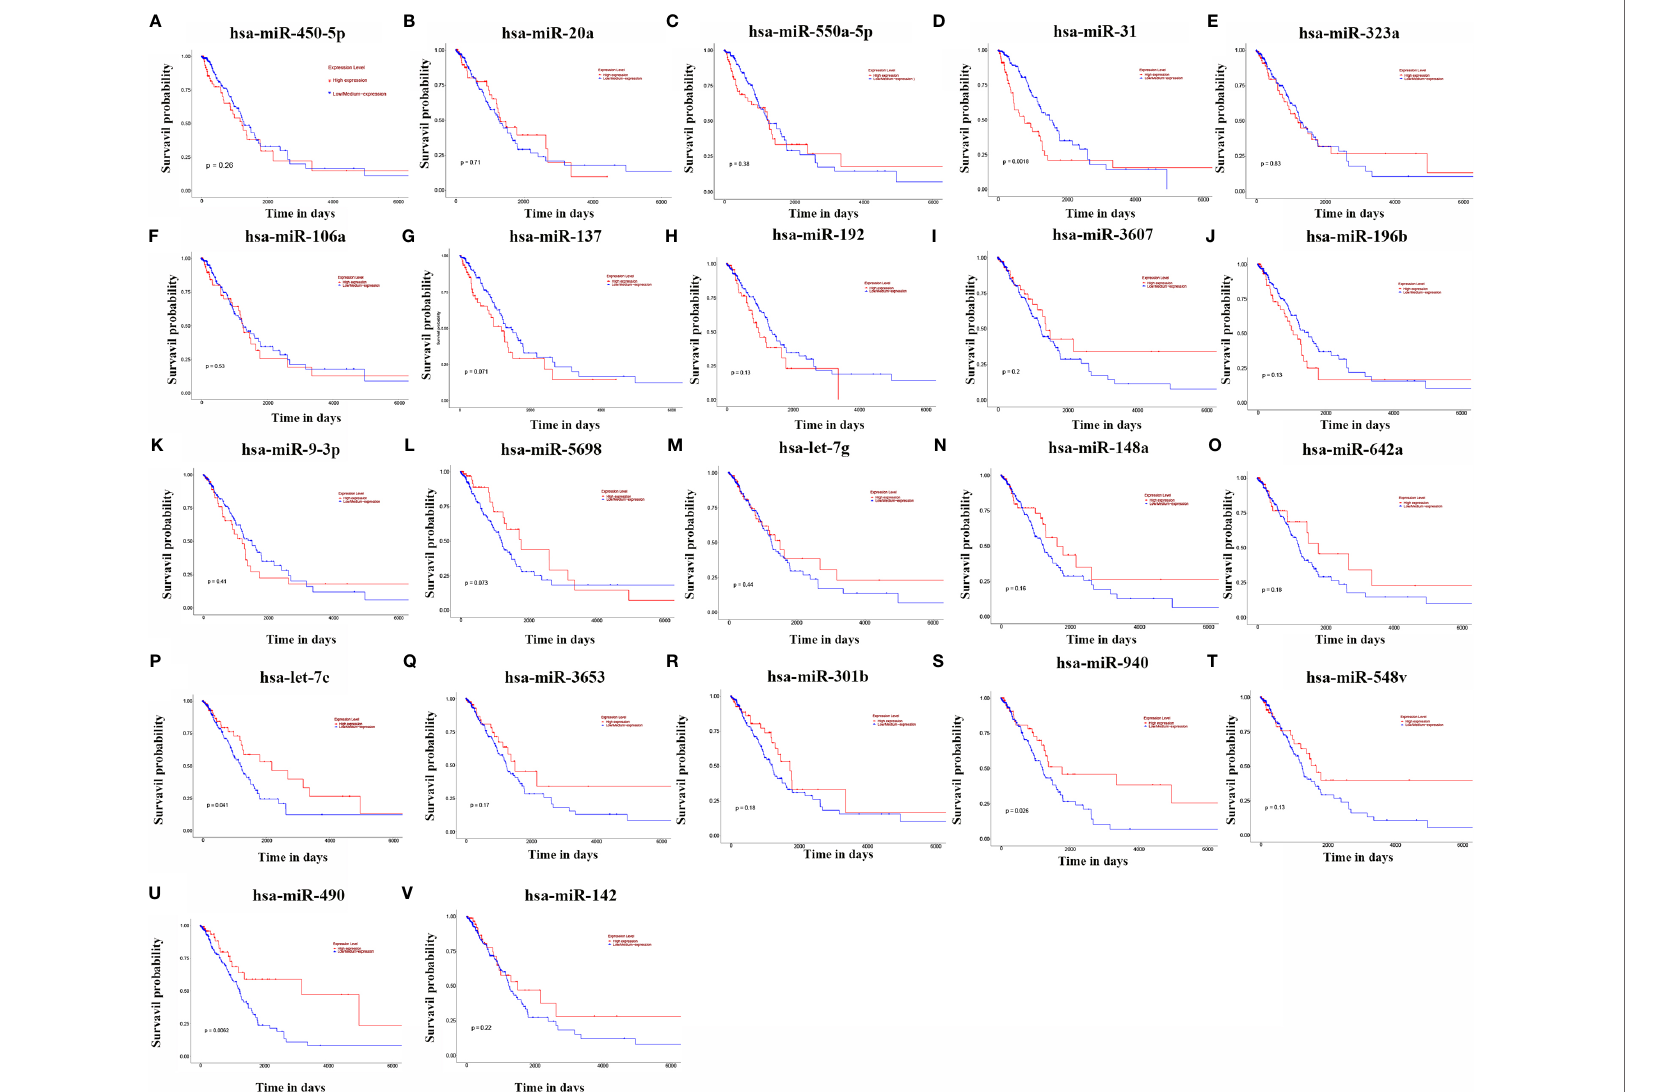
FIGURE 2 | KM curves of 23 miRNAs. ( A : hsa-miR-450a-5p; B : hsa-miR-20a; C : hsa-miR-550a-5p; D : hsa-miR-31; E : hsa-miR-323a; F : hsa-miR-106a; G : hsa-miR-137; H : hsa-miR-192; I : hsa- miR-3607; J : hsa-miR-196b; K : hsa-miR-9-3p; L : hsa-miR-5698; M : hsa-let-7g; N : hsa-miR-148a; O : hsa-miR-642a; P : hsa-let-7c; Q : hsa-miR-3653; R : hsa -miR-301b; S : hsa-miR-940; T : hsa-miR-548v; U : hsa-miR- 490; V :